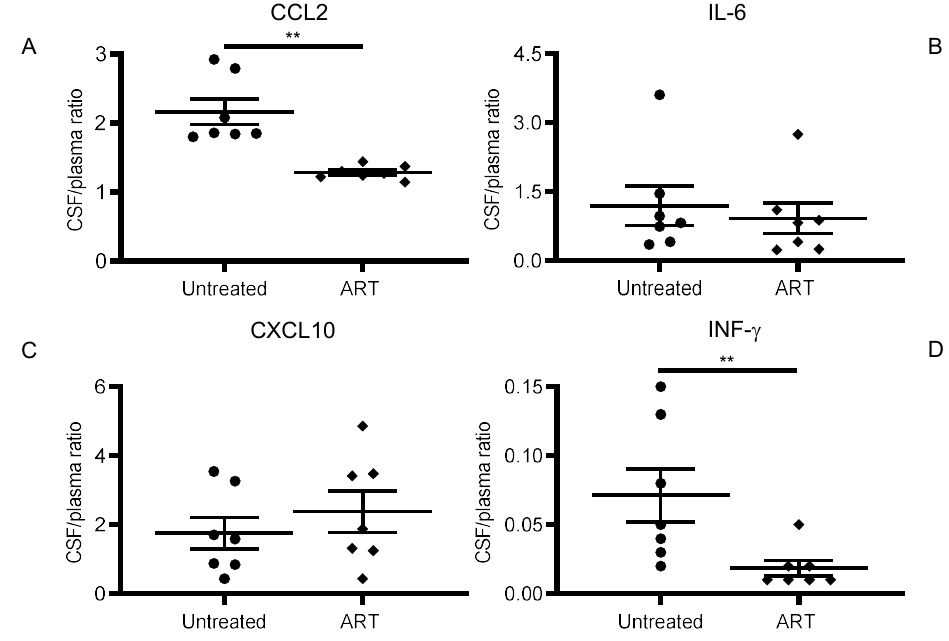
Figure 4. CSF/Plasma ratio difference between Untreated and ART groups. The graphs show the distribution observed in the CSF/Plasma ratio of the experimental groups for ( A ) CCL2, ( B ) IL-6, ( C ) CXCL10, and ( D ) IFN- γ (** p < 0.01).